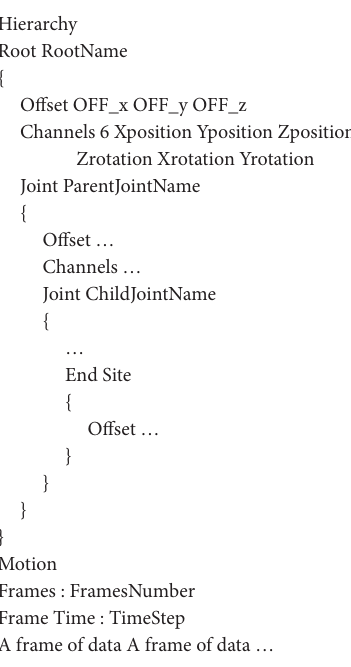
Figure 7: An example of a BVH